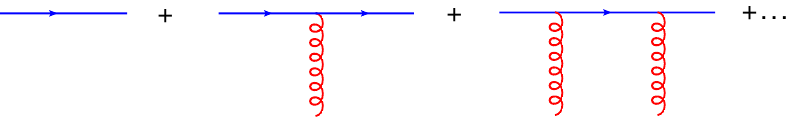
Figure 4 . Diagrammatic expansion of the quark propagator in the external (cid:12)eld. Quantum (cid:12)elds are in blue, while classical (cid:12)elds are in red as